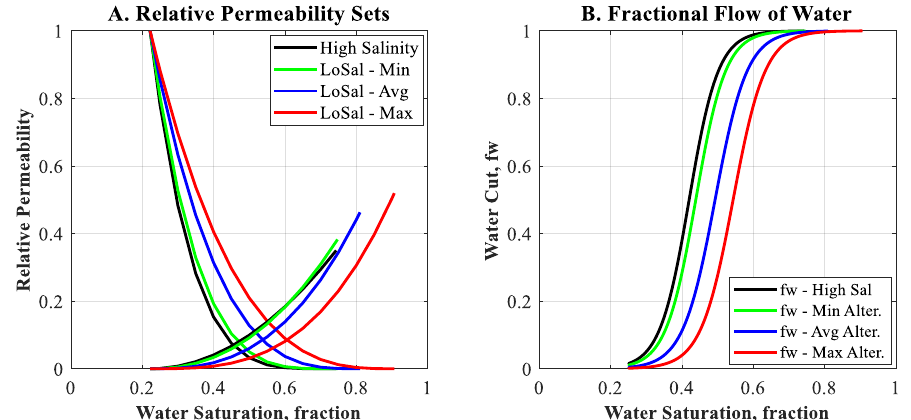
Figure 7. The effect of low salinity waterflooding on the relative permeability curves. ( A ) Generated relative permeability sets due to wettability alteration and residual oil saturation. ( B ) Fractional flow of water for the generated relative permeability sets, where the water breakthrough time delayed by 47% when maximum alteration used (indicated by red legend) compared to the high salinity set (indicated by black legend).